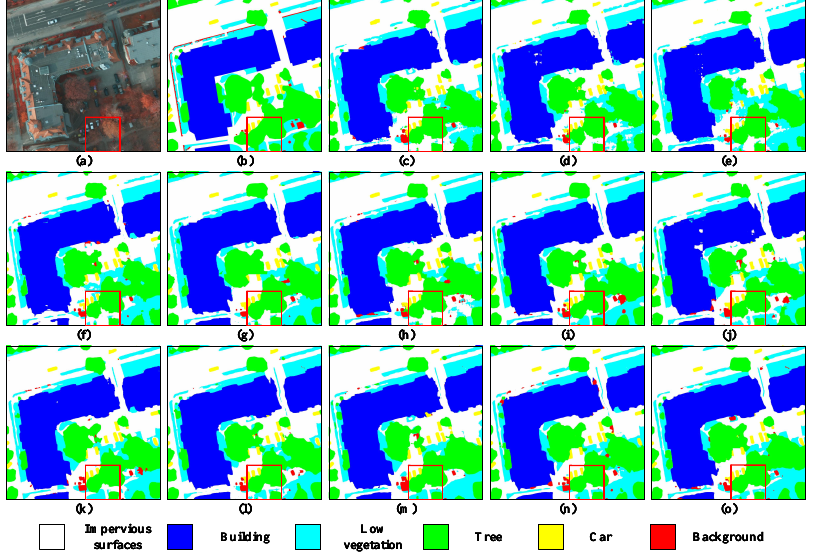
Figure 8. Examples of segmentation results derived from the Potsdam dataset under the small size setting. ( a ) IRRG image. ( b ) Ground truth. ( c ) FPENet. ( d ) FSSNet. ( e ) CGNet. ( f ) ContextNet. ( g ) Fast-SCNN. ( h ) ERFNet. ( i ) STDC1. ( j ) LinkNet. ( k ) ICNet34. ( l ) BiSeNet V1. ( m ) SFNet. ( n ) DDRNet23. ( o )